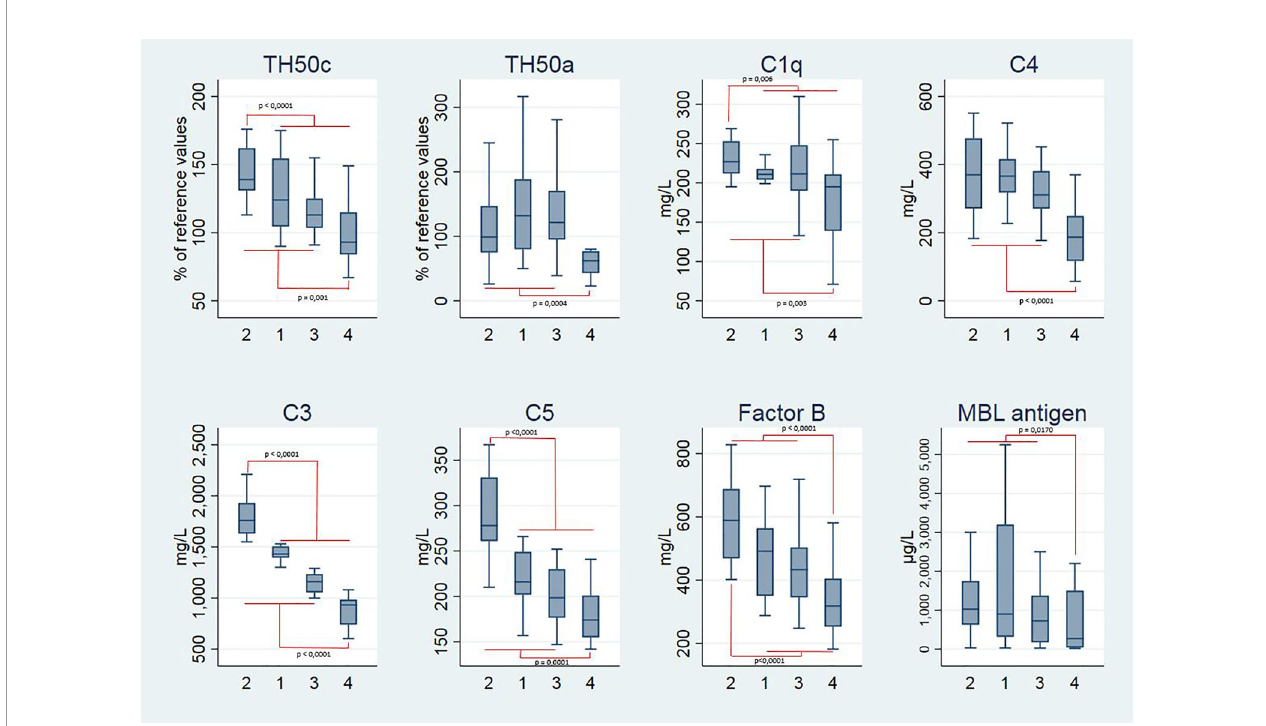
FIGURE 1 | Boxplots representing the complement parameters of the four clusters of patients. Statistical analysis by hierarchical ascendant clustering discriminates the 74 patients with COVID-19 of the cohort in four distinct clusters according to complement variables: TH50c, TH50a, C1q, C4, C3, C5, Factor B, and MBL antigen. Age was included in the model. Boxplots represent the median and 25 th to 75 th percentiles, the whiskers denote the maximum and minimum values, and the horizontal bars indicate the medians. Outside values were